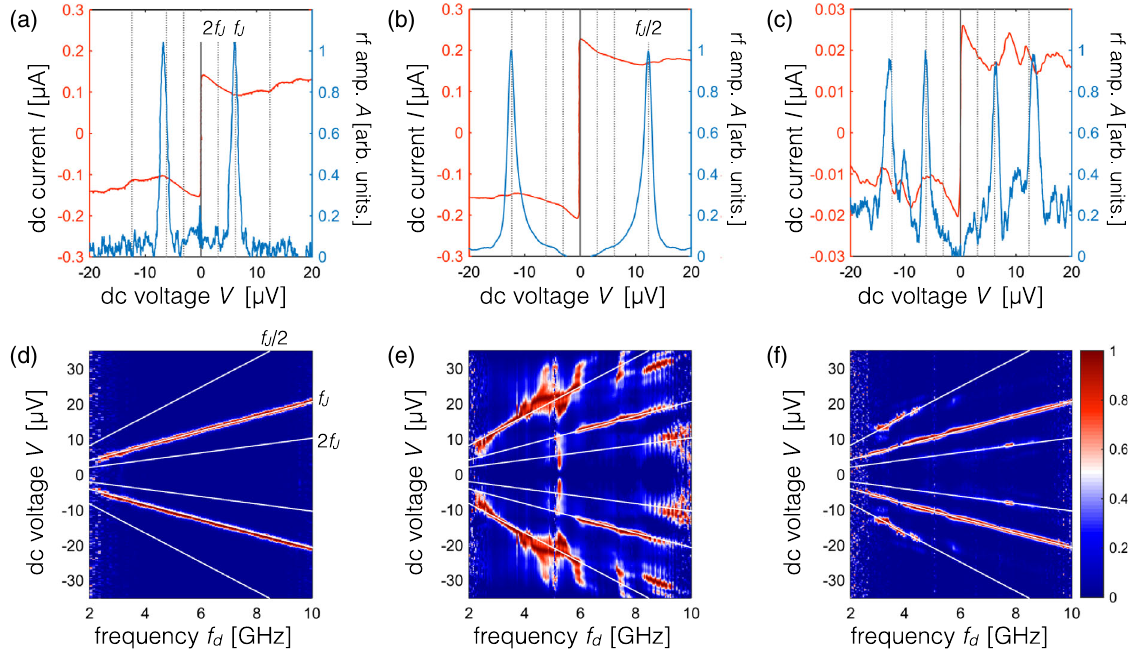
FIG. 2. Emission spectra. (a) – (c) I - V curves (red lines) and emission spectrum (blue lines) for a nontopological weak link (a) and a quantum spin Hall weak link [(b) at V ≃ 3 GHz when sweeping the bias. Gray dashed lines indicate the expected values of 2 f f d lines). (d) – (f) Two-dimensional plot of the power collected from the devices, as a function of voltage V and detection frequency f in the nontopological weak link and (e) and (f) in the topological weak link for, respectively, V lines indicate the expected resonance lines at 2 f to their maximum for each frequency. In (e), additional features for frequencies f resonant features in the electromagnetic environment of the junction. Their influence is examined in Sec. III of SM